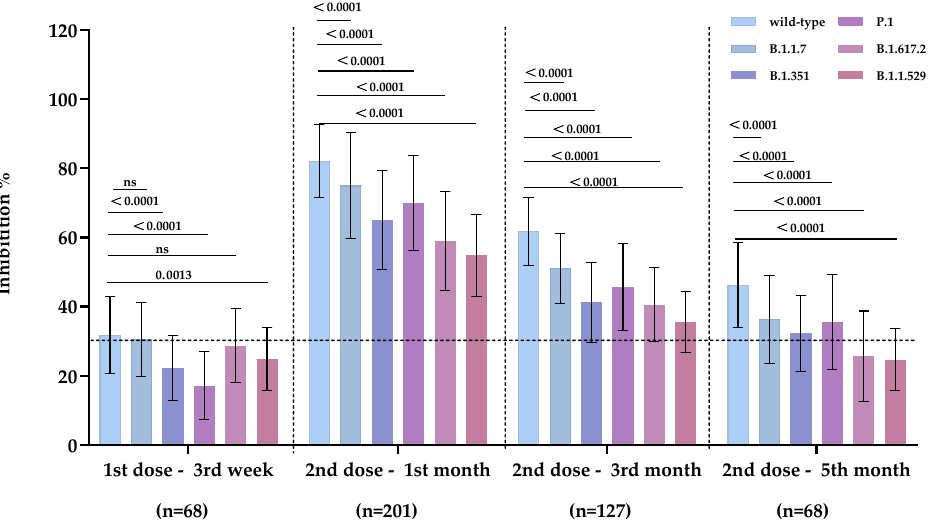
Figure 2. Antibodies induced by the primary inactivated vaccine exhibited inhibitory activity against wild-type, B.1.1.7, B.1.351, P.1, B.1.617.2 and B.1.1.529. Detection time points: 3rd week after the first dose (n = 68), 1st month (n = 201), 3rd month (n = 127), and 5th month (n = 68) after the second dose of inactivated vaccine. The dotted lines represent the cutoff at 30% inhibition. ns: no